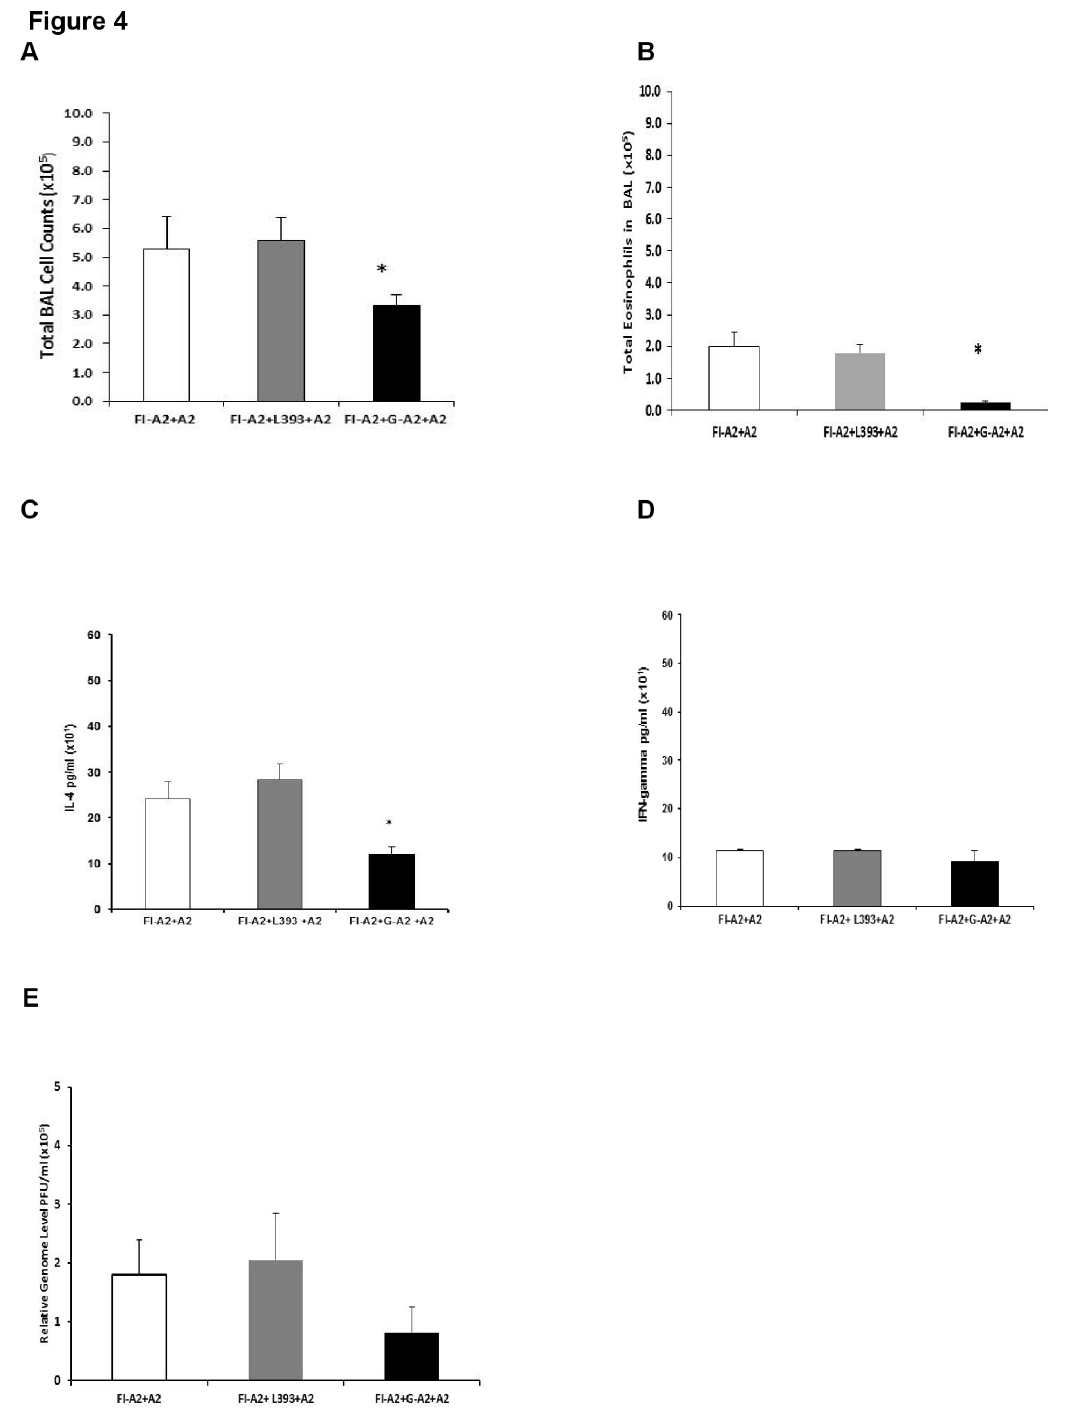
Figure 4. Decreased pulmonary cell inflammatory response in FI-A2 and G-A2 peptide vaccinated mice after RSV challenge. Mice were i.m. vaccinated with formalin inactivated RSV A2 (FI-A2) and then s.c. vaccinated with RSV A2 G peptide (FI-A2+G-A2) and control peptide (FI-A2 + L393). Two weeks following the final peptide boost, groups were challenged with live RSV A2 and the mean numbers of BAL cells/lung (A), total eosinophil counts in the BAL (B), IL-4 levels (pg/ml) (C) and IFN gamma (D) in the cell-free BAL supernatant, and viral message levels (relative genome equivalent PFU/ml) (E) at day 5 post-challenge (peak of cell infiltration) were determined. Representative data from five independent experiments are shown. * p<0 . 05 . doi: 10.1371/journal.pone.0083075.g004 PLOS ONE |